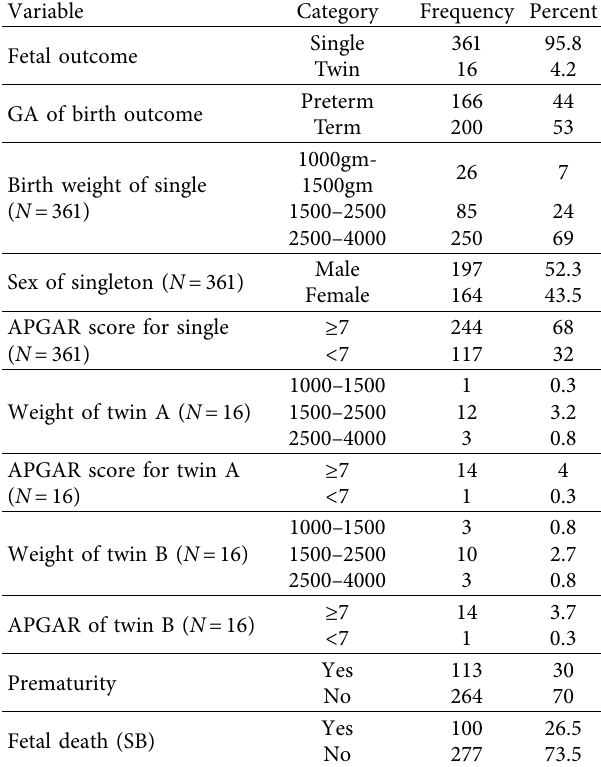
Table 6: Fetal outcome of women presented with